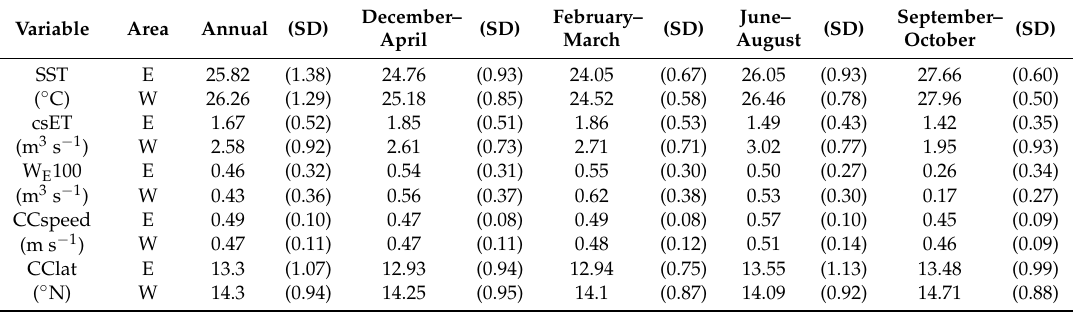
Figure 7. Seasonal weekly averages of SST, upwelling transport, and Caribbean Current maximum speed for the west ( left ) and east ( right ) upwelling areas (see areas in Figure 1a). The mid-year upwelling period (gray bar) and peak (straight black line) are highlighted. ( a , b ) SST averaged within the west and east areas. ( c , d ) Upwelling transport generated by alongshore winds (csET), by the wind curl integrated from the coast to 100 km offshore (W E 100), and total transport (csET plus W E 100) averaged over the longitudes of the west and east areas. ( e , f ) Speed at the core of the maximum of the Caribbean Current (CCspeed) was averaged over the longitudes corresponding to the west and east areas. All variables were filtered with a centered 3-week running mean. Table 1. Seasonal statistics (averages and standard deviation) of satellite-derived dynamic parameters on the east and west upwelling areas of the southern Caribbean